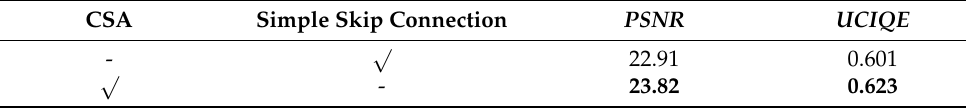
Table 5. Results of the ablation experiments on CSA.